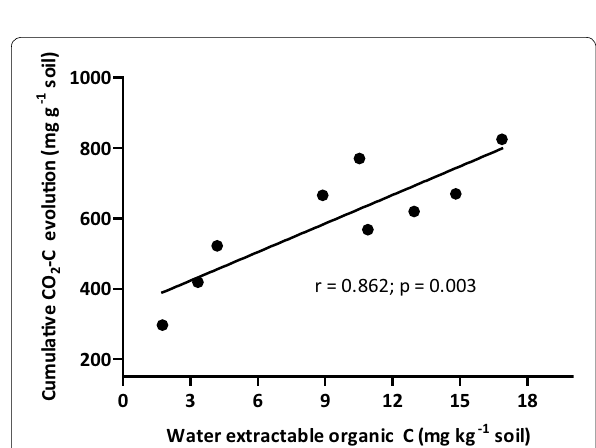
Fig. 4 Relationship between cumulative CO 2 efflux and water extractable organic